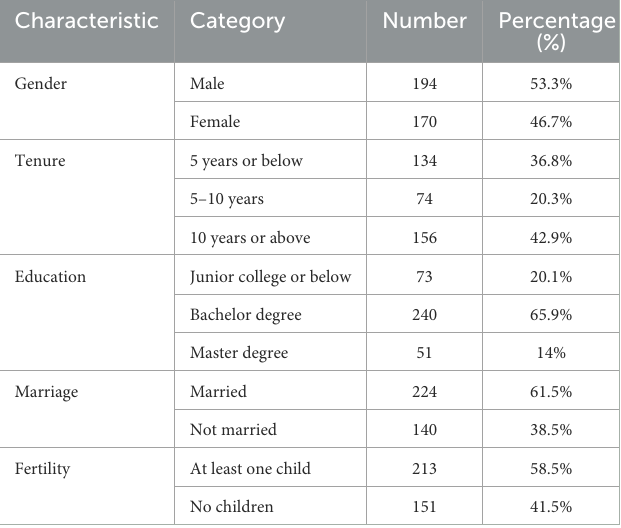
TABLE 1 Descriptive characteristics of samples ( n =